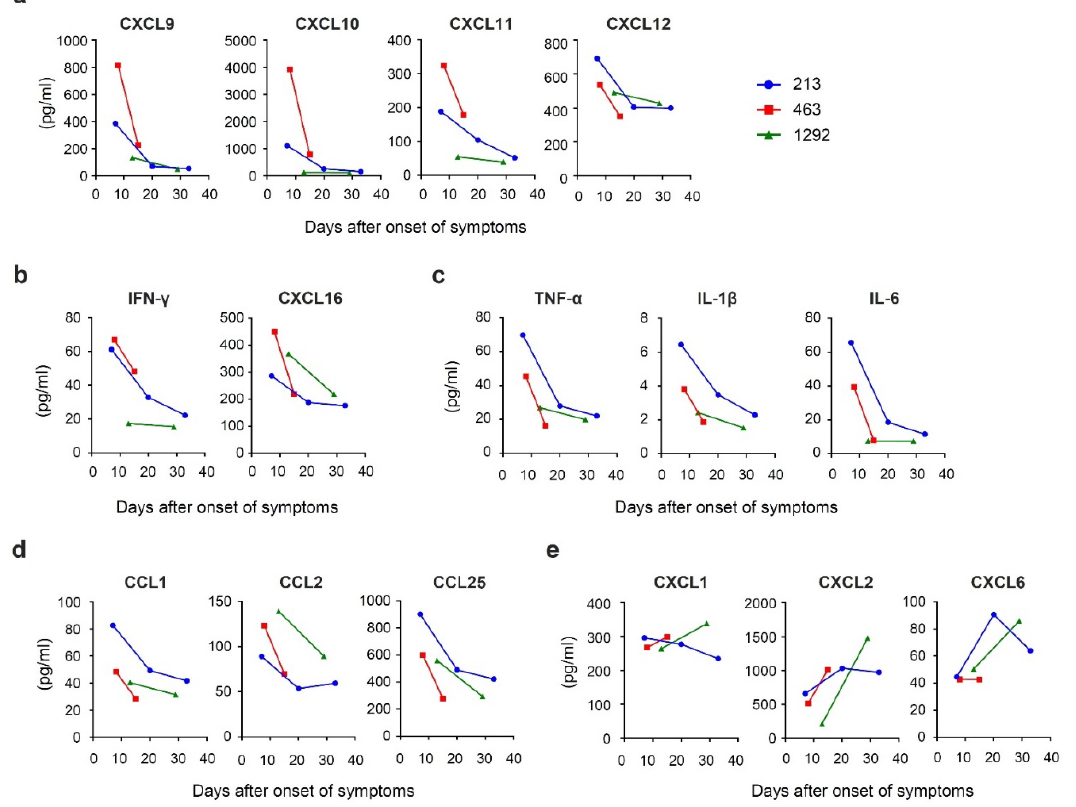
Figure 2. Changes of cytokine profile after clinical onset of HAV infection. Measurements of ( a ) CXCL9, CXCL10, CXCL11, and CXCL12; ( b ) IFN- γ and CXCL16; ( c ) tumor necrosis factor (TNF)- α , interleukin (IL)-1 β , and IL-6; ( d ) CCL1, CCl2, and CCL25; and ( e ) CXCL1, CXCL2, and CXCL6 in serum of patients. The clinical onset was set to day 1.